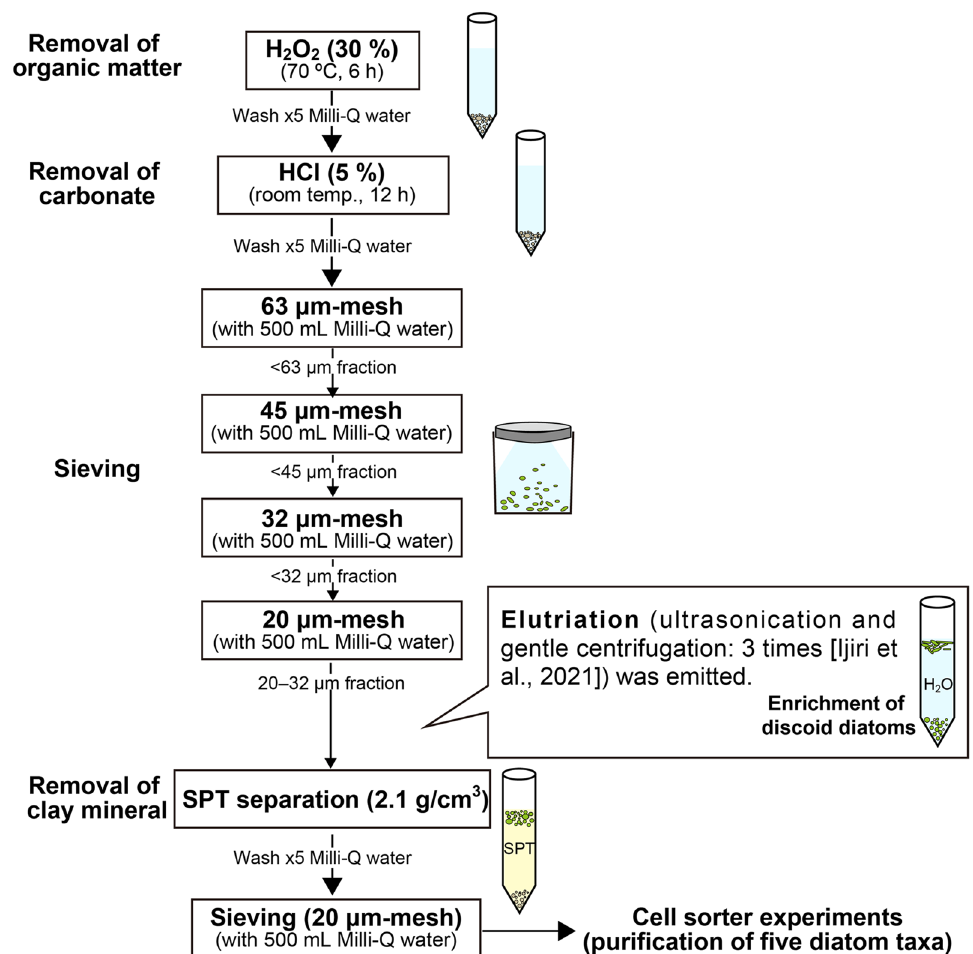
Fig. 2 Flow diagram showing the pretreatment process for concentration of diatom